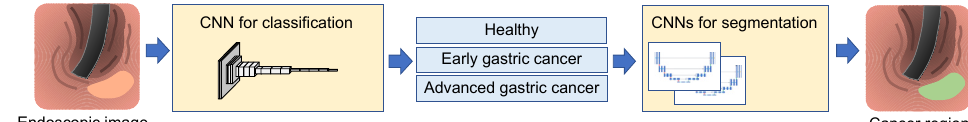
Figure 1. Outline of the proposed method.